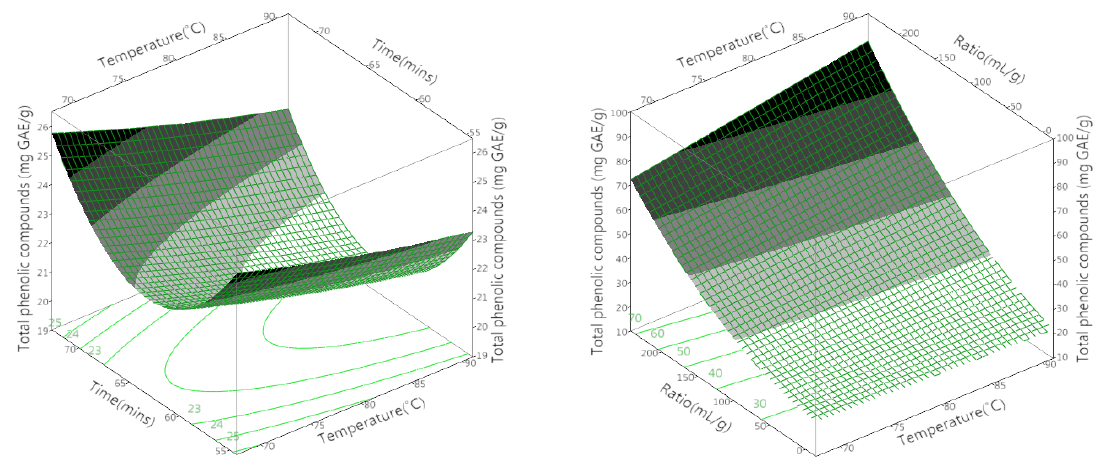
Figure 3. 3D response surface and 2D contour plots for the effects of the test parameters on total phenolic